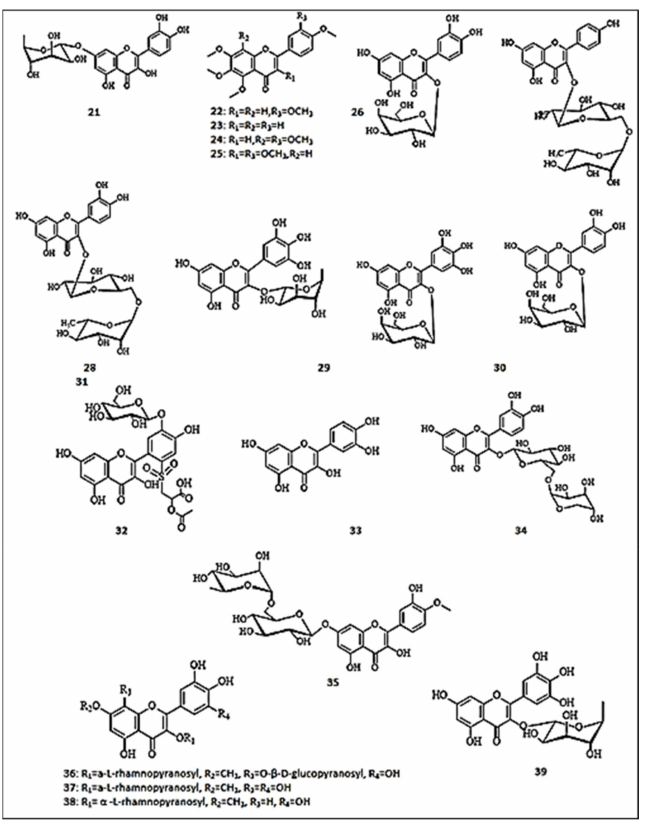
Figure 3. The chemical structures of flavonols with anti-tyrosinase activity. ( 21 ) Quercetin-7- O - α - L - rhamnpyranoside; ( 22 ) Sinensetin; ( 23 ) 4 (cid:48) ,5,6,7-tetramethoxyflavone; ( 24 ) Nobiletin; ( 25 ) 3,3 (cid:48) ,4 (cid:48)